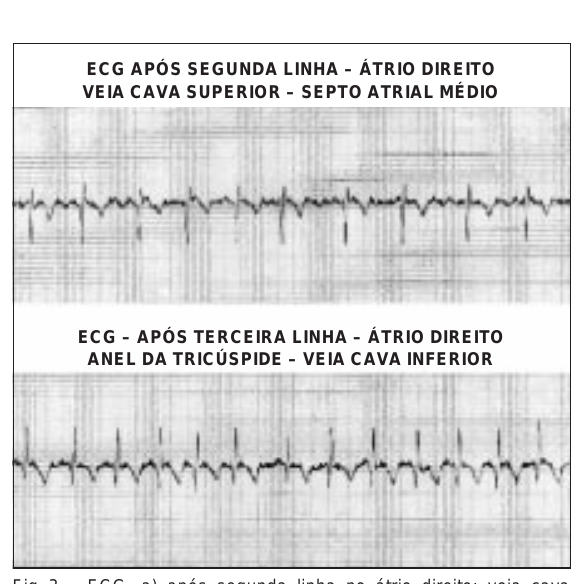
Fig. 3 - ECG. a) após segunda linha no átrio direito: veia cava superior – septo atrial médio; b) após terceira linha no átrio direito: anel da valva tricúspide – veia cava inferior.